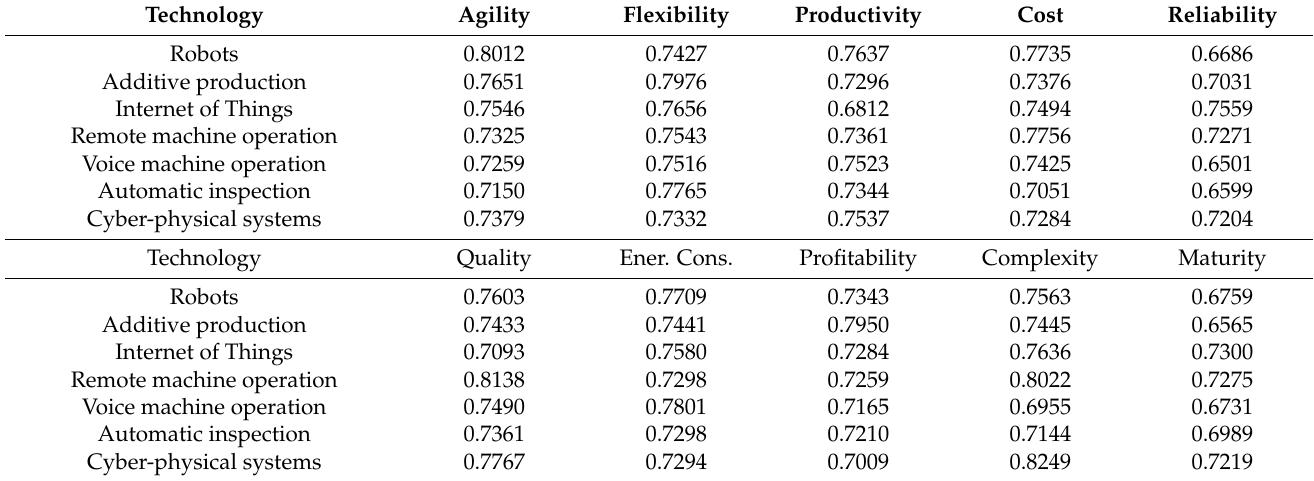
Table A11. The overall utility matrix of weighted arithmetic sequence.